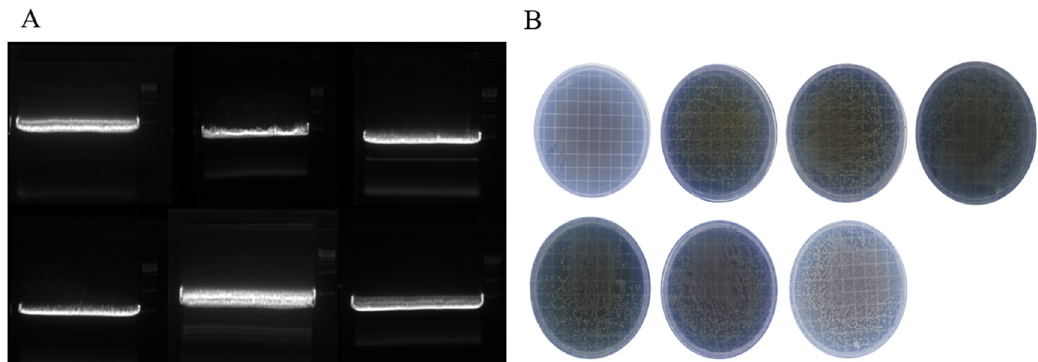
Figure 3. Cut-glue recovery and ligation transformation. ( A ): indicates the results of cut-glue recovery, LA, LB, and LC in the first row in order; and LD, LF, and ST in the second row in order. ( B ): indicates the results of growth on Amp-resistant culture plates after ligation transformation, negative control, LA, LB, LC, LD, LF, and ST in the first row in order.